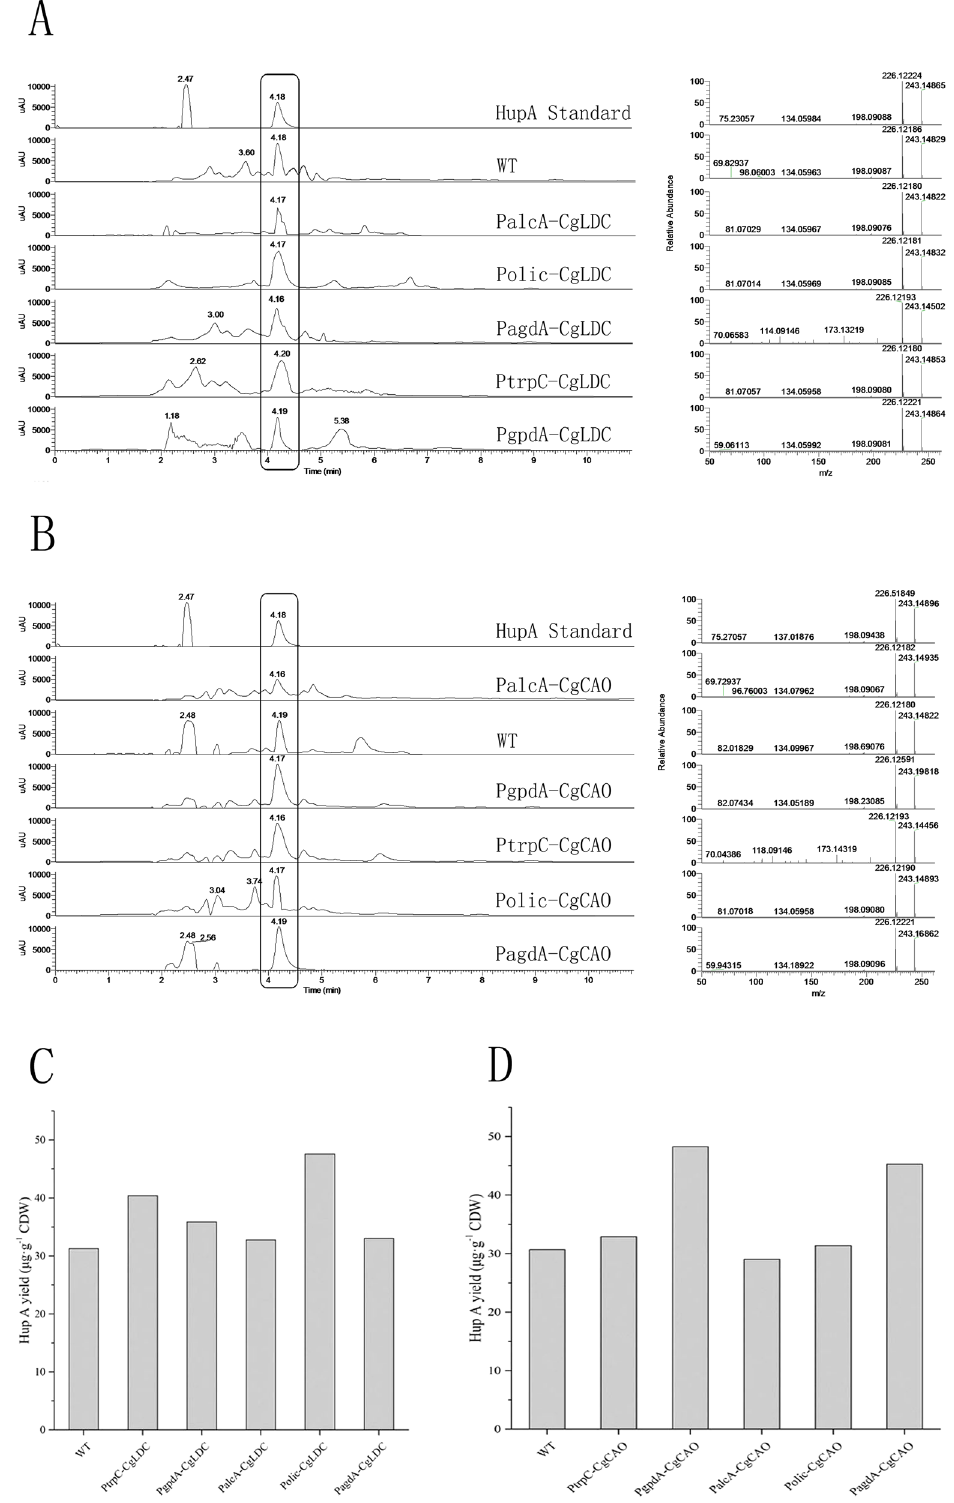
Figure 8. HupA yield from C . gloeosporioides ES026 and C . gloeosporioides ES026 transformants. ( A ) LC-HRMS analysis results of wild-type C . gloeosporioides ES026 and PtrpC-CgLDC, PgpdA-CgLDC, PalcA-CgLDC, Polic- CgLDC, and PagdA-CgLDC transformants. ( B ) LC-HRMS analysis results of HupA yields from wild-type C . gloeosporioides ES026 and PtrpC-CgCAO, PgpdA-CgCAO, PalcA-CgCAO, Polic-CgCAO, and PagdA-CgCAO transformants. ( C ) HupA yields from wild-type C . gloeosporioides ES026 and PtrpC-CgLDC, PgpdA-CgLDC, PalcA- CgLDC, Polic-CgLDC, and PagdA-CgLDC transformants. ( D ) HupA yields from wild-type C . gloeosporioides ES026 and PtrpC-CgCAO, PgpdA-CgCAO, PalcA-CgCAO, Polic-CgCAO, and PagdA-CgCAO